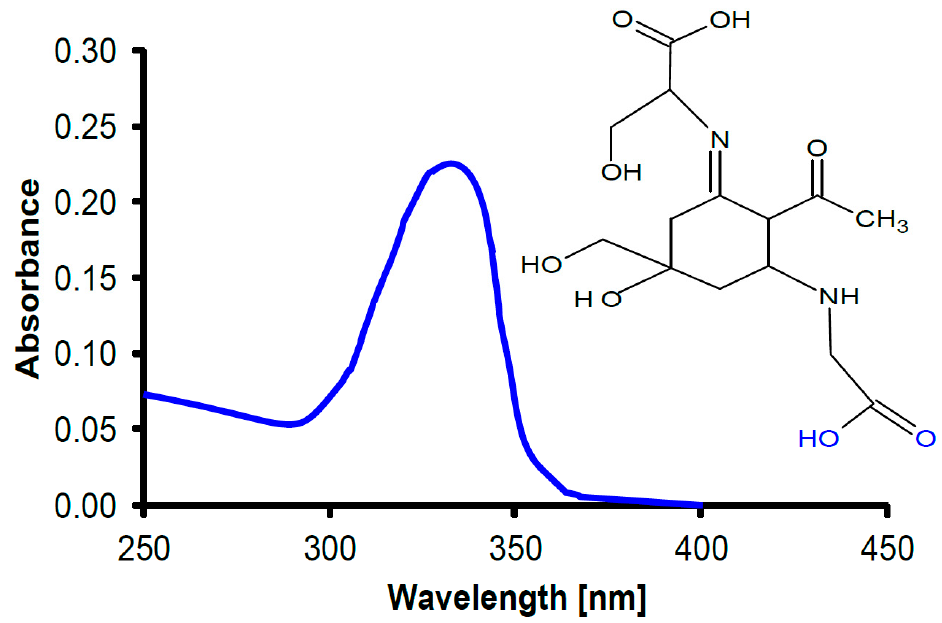
Figure 3. Chemical structure and absorption spectrum of the mycosporine-like amino acid shinorine found in many prokaryotic and eukaryotic phytoplankton species, as well as some macroalgae.